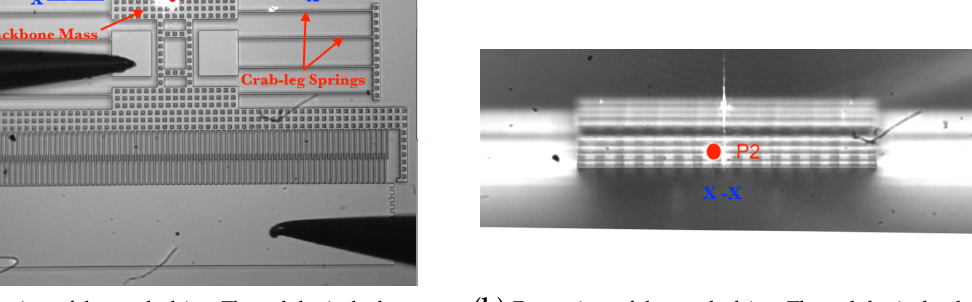
Figure 2. Top and front views of the actuator.